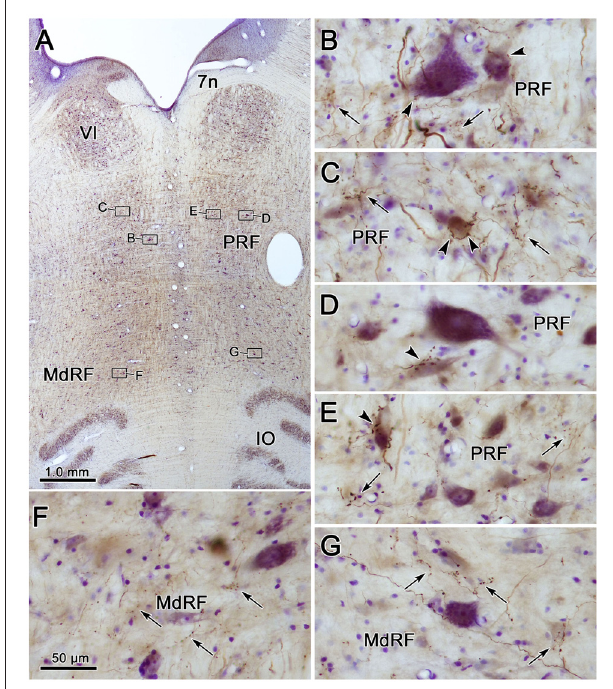
FIGURE 3 | Morphology of reticuloreticular axons labeled by BDA. (A) Low magnification photomicrograph of a section through the abducens nucleus showing the location of the higher magnification plates in this figure (labeled boxes). Some of the BDA labeled axons displayed close associations with counterstained somata (arrowheads), while others terminated in the neuropil (arrows). The images were taken from the ipsilateral PRF (B,C) , contralateral PRF (D,E) , ipsilateral MdRF (F) and contralateral MdRF (G) . The case shown is the same as illustrated in Figure 2 . (Number of 1.0 µ m Z axis planes merged: B,C,E = 3, D,F = 1, G =